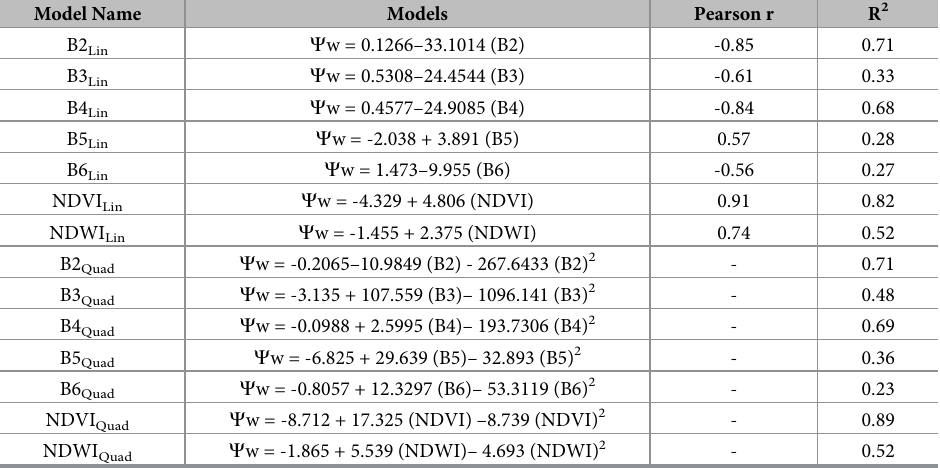
Table 2. Regression models and coefficient of determination (R 2 ). Where B represents the satellite’s spectral